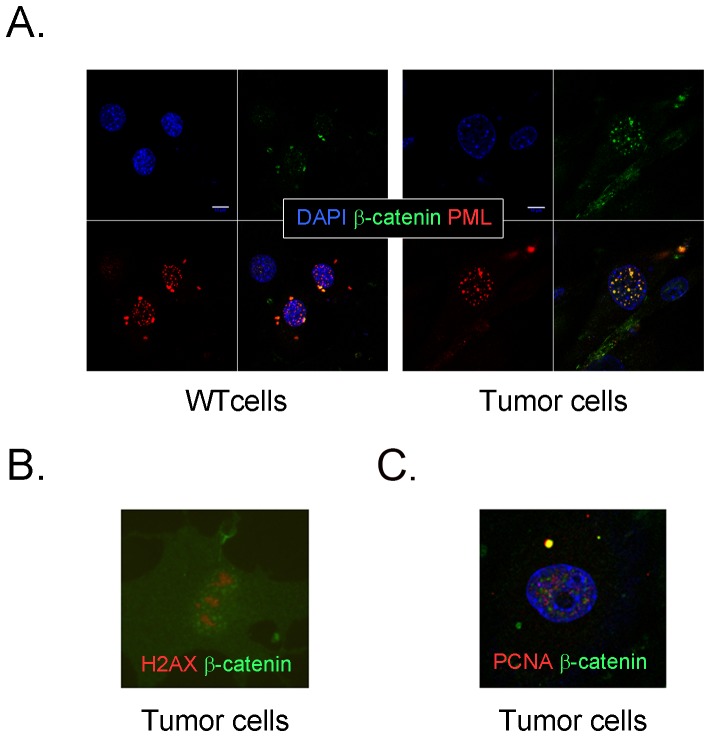
β-catenin (green) localizes to PML bodies in Prkar1a+/− tumor osteoblasts.A. Triple immunofluorescence for DAPI (blue), β-catenin (green), and PML (red) in WT or Tumor osteoblasts. The bottom right image in each panel represents the merged image. Scale bar: 10 µm. B. Immunofluorescence for H2AX and β-catenin in tumor cells. C. Immunofluorescence for PCNA and β-catenin. Note the lack of co-localization between proteins in B and C. Magnification (B and C): 630x.